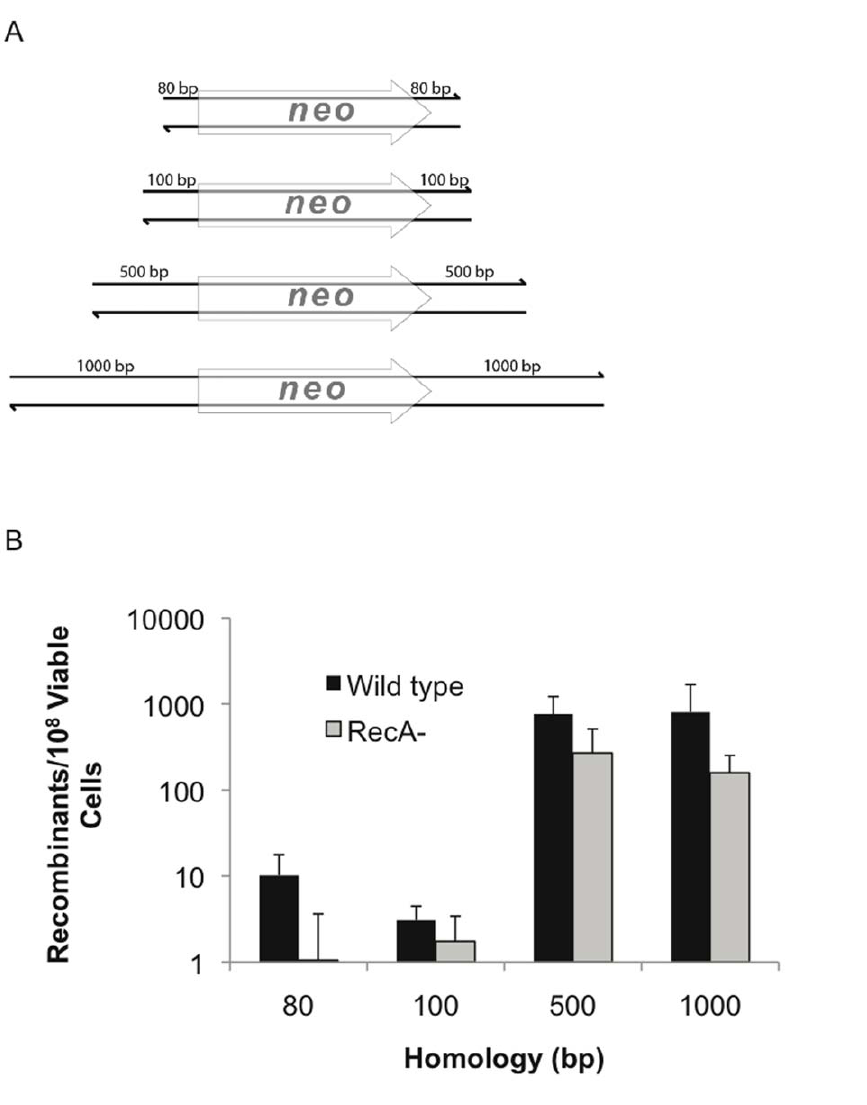
Figure 2. RecTE Psy -mediated recombination frequency is sensitive to flank length. (A) Recombination substrates were generated by PCR using primers that flank the D PSPTO_1203:: neo allele to produce substrates with homologies of indicated lengths. For example, each of the substrates is composed of the neo gene flanked by the indicated amount of genomic sequence. The substrate was then gel purified and 0.46 pmol of each substrate was used to electroporate cells containing the RecTE Psy expression vector or empty vector (0.46 pmol corresponds to 200 ng of the 80 bp flanks substrate). (B) Recombination frequencies with these substrates in wild-type and recA 2 P. syringae pv. tomato DC3000 with pUCP24/ recTE are shown. The results are the average of at least three independent replicates, error bars indicate standard deviation. No kanamycin resistant colonies were observed in control transformations of cells containing the pUCP24/61 empty vector (no RecTE Psy ). PCR was used to confirm that for each length tested the kanamycin resistance gene had integrated into the correct